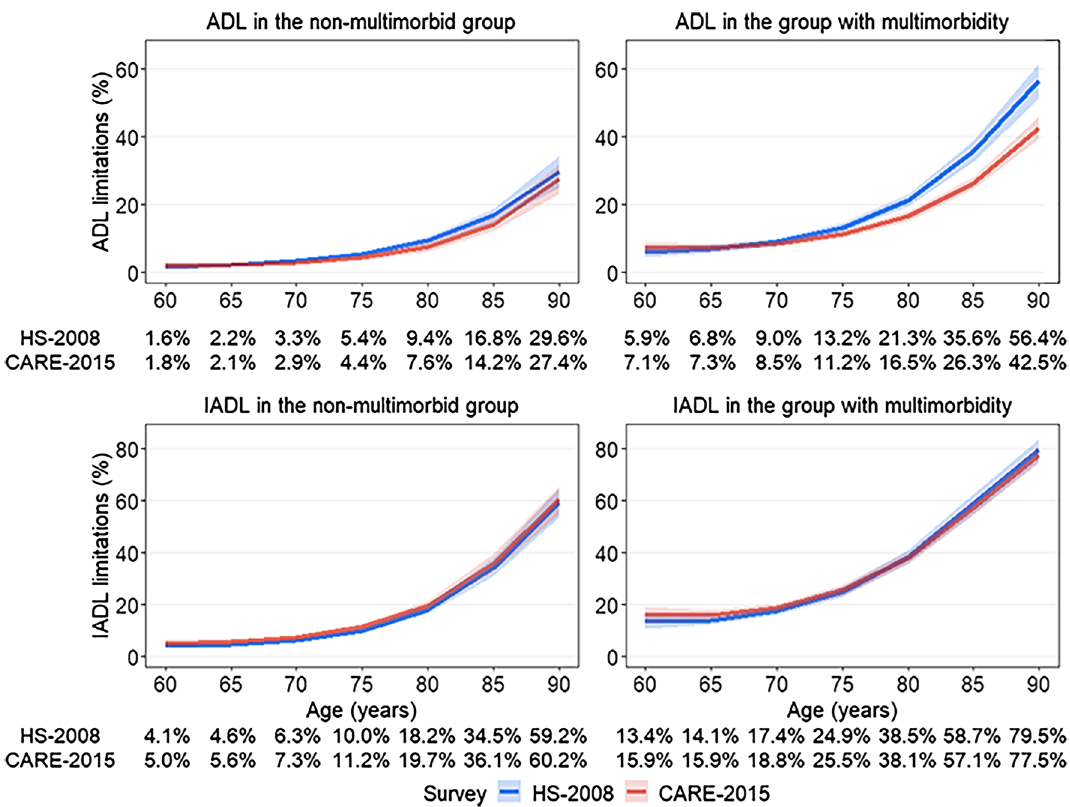
Figure 2. Prevalence of ADL and IADL limitations in HS-2008 and CARE-20155 survey, by age and multimorbidity status a . HS: Handicap Santé,;CARE: Capacities, Aids and REssources; ADL: Activities of Daily Living; IADL: Instrumental Activities of Daily Living. a Estimated using weighted logistic models stratified on multimorbidity status and adjusted for survey (HS-2008, CARE-2015), age, age 2 , survey x age, sex, education, and for significant interactions between covariates and age